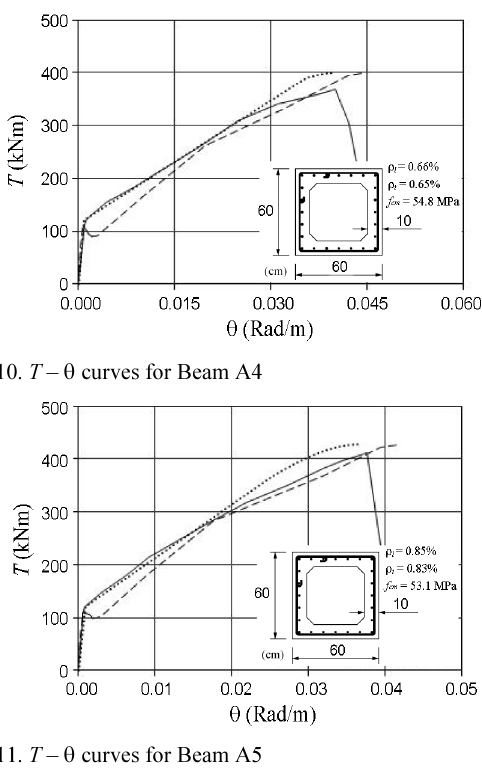
Fig. 15. T – θ curves for Beam B5